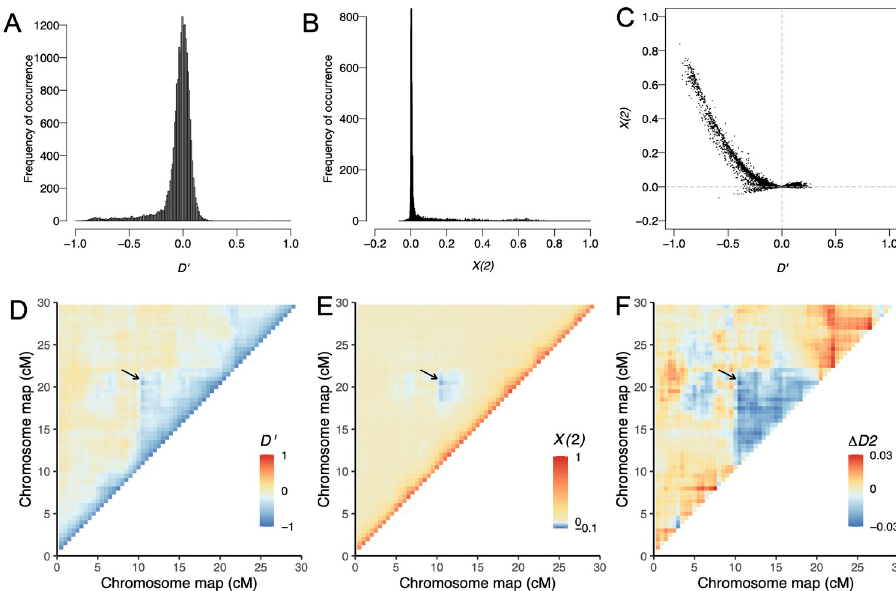
Fig 3. Negative X (2) indicates an intrachromosomal DMI in simulated data. We show the distribution of X (2), D 0 , and Δ D 2 of a chromosome with a DMI pair at generation 50 under a Wright-Fisher model for one simulation run using SliM. The direct selection coefficients are α = 0.001, β = 0.002. The strength of epistasis is γ = − 0.5. The interacting loci generating the DMI are located at 10 cM and 20 cM, such that the recombination probability is c = 0.1 between the two loci. A-C. The distribution of X (2) and D 0 and their joint distribution within the chromosome. We observe negative X (2) values and negative D ’ values at the two loci involved in the DMI and in flanking regions that are tightly linked to the DMI. D-F. Heatmaps of D 0 , X (2) and the Δ D 2 within the simulated chromosome. Only the DMI region and its 10 cM flanking regions are shown in D-F. The DMI is highlighted by a black